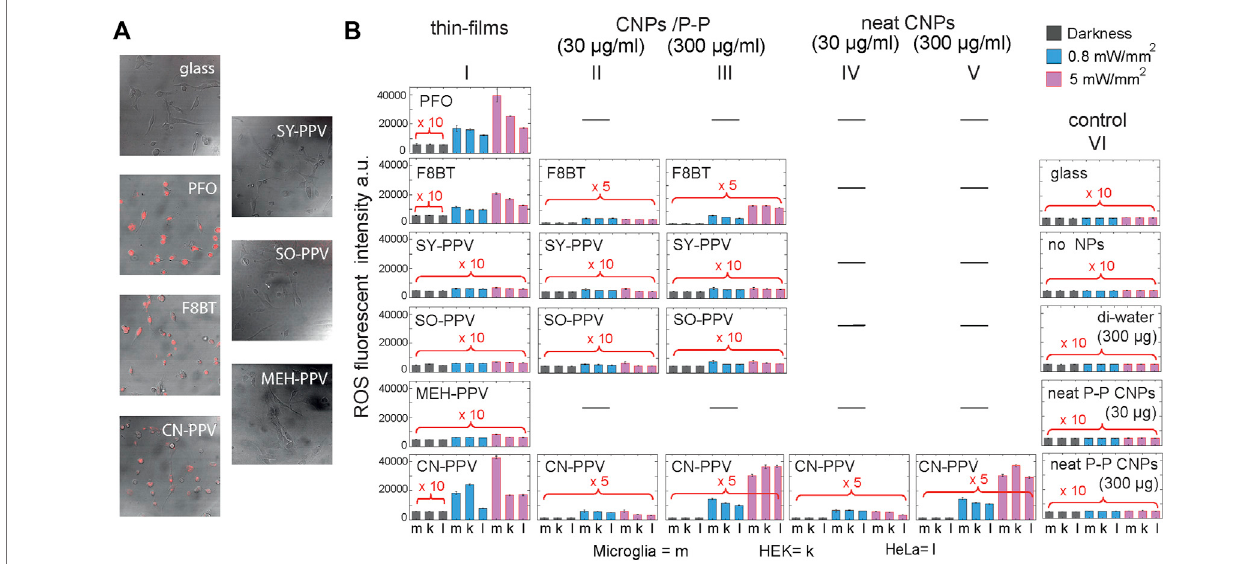
FIGURE 3 | Analysis of photogenerated reactive oxygen species (ROS) by light-emitting conjugated polymers in fi lm and nanoparticle form. (A) Microscope image of ROS level in red for SV40 cells grown on top of solid-state thin- fi lm of the six conjugated polymers and glass control following irradiation. (B) Fluorescent assay quantifying ROS intensity in the dark (gray bars) and after irradiation with optical power of 0.8 mW/mm 2 (blue) or 5 mW/mm 2 (pink) at peak emission at 390 nm for PFO, 473 nmforCN-PPV, F8BT, SY-PPV,and SO-PPV, and548 nm forMEH-PPV, forHEK239,HeLa,and SV40cellsgrown onconjugatedpolymerthin fi lms(column 1), CNPs encapsulated with PEG-PLGA seeded at 30 μ g/ml (column 2) and CNPs seeded at 300 μ g/ml (column 3), 100% neat CN-PPV nanoparticles (columns 4 – 5) and control glass, no CNPs, only Di-water (300 µg) and only neat PEG-PLGA (30 µg or 300 µg) (all controls, column 6). To aid in visualization, some bars have been magni fi ed by a factor of fi ve or 10 (red